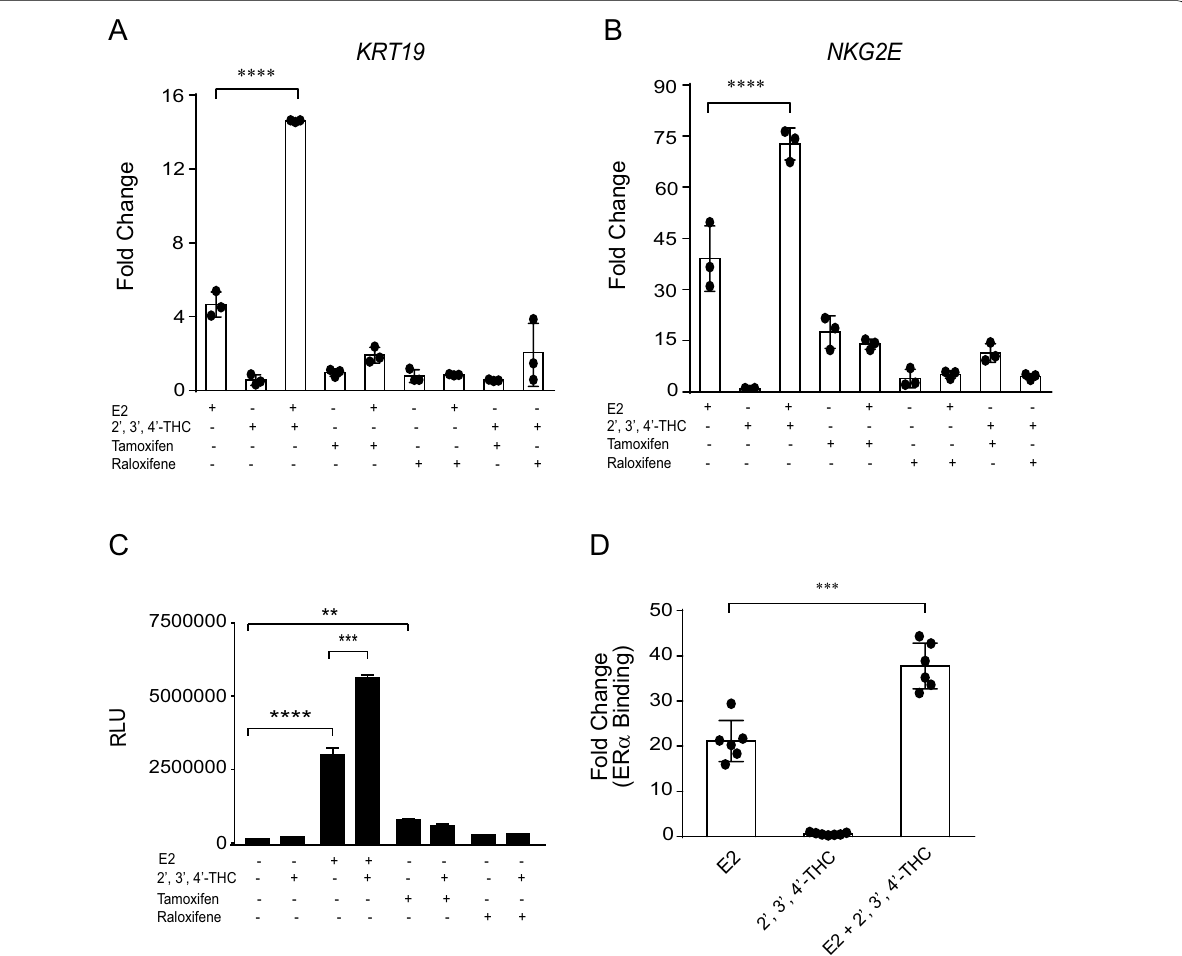
Fig. 5 2 ′ ,3 ′ ,4 ′ ‑THC acts differently from SERMs on gene transcription . A KRT19 and B NKG2E gene expression in U2OS‑ERα cells treated with 10 nM E2 or 5 μM 2 ′ ,3 ′ ,4 ′ ‑THC in the absence and presence of 1 μM tamoxifen or 1 μM raloxifene alone or in combination for 24 h. The mRNA levels were determined by qRT‑PCR. C U2OS cells cotransfected with ERα and NKG2E‑TK‑Luc were treated with 10 nM E2, 5 μM 2 ′ ,3 ′ ,4 ′ ‑THC, 5 μM tamoxifen, and 1 μM raloxifene alone or in combination for 24 h. Luciferase activities were measured with a luminometer. D ERα recruitment to the KRT19 ERE in U2OS‑ERα cells was determined with ChIP assay after the cells were treated with 10 nM E2 and 5 μM 2 ′ ,3 ′ ,4 ′ ‑THC alone or in combination for 2 h. The KRT19 gene was used because the ERE was previously characterized and the ERE in the reprogrammed genes is not known. The data shown are the mean of triplicate samples SE. The statistical significance was determined by one‑way ANOVA followed by Tukey’s multiple comparisons post ± hoc